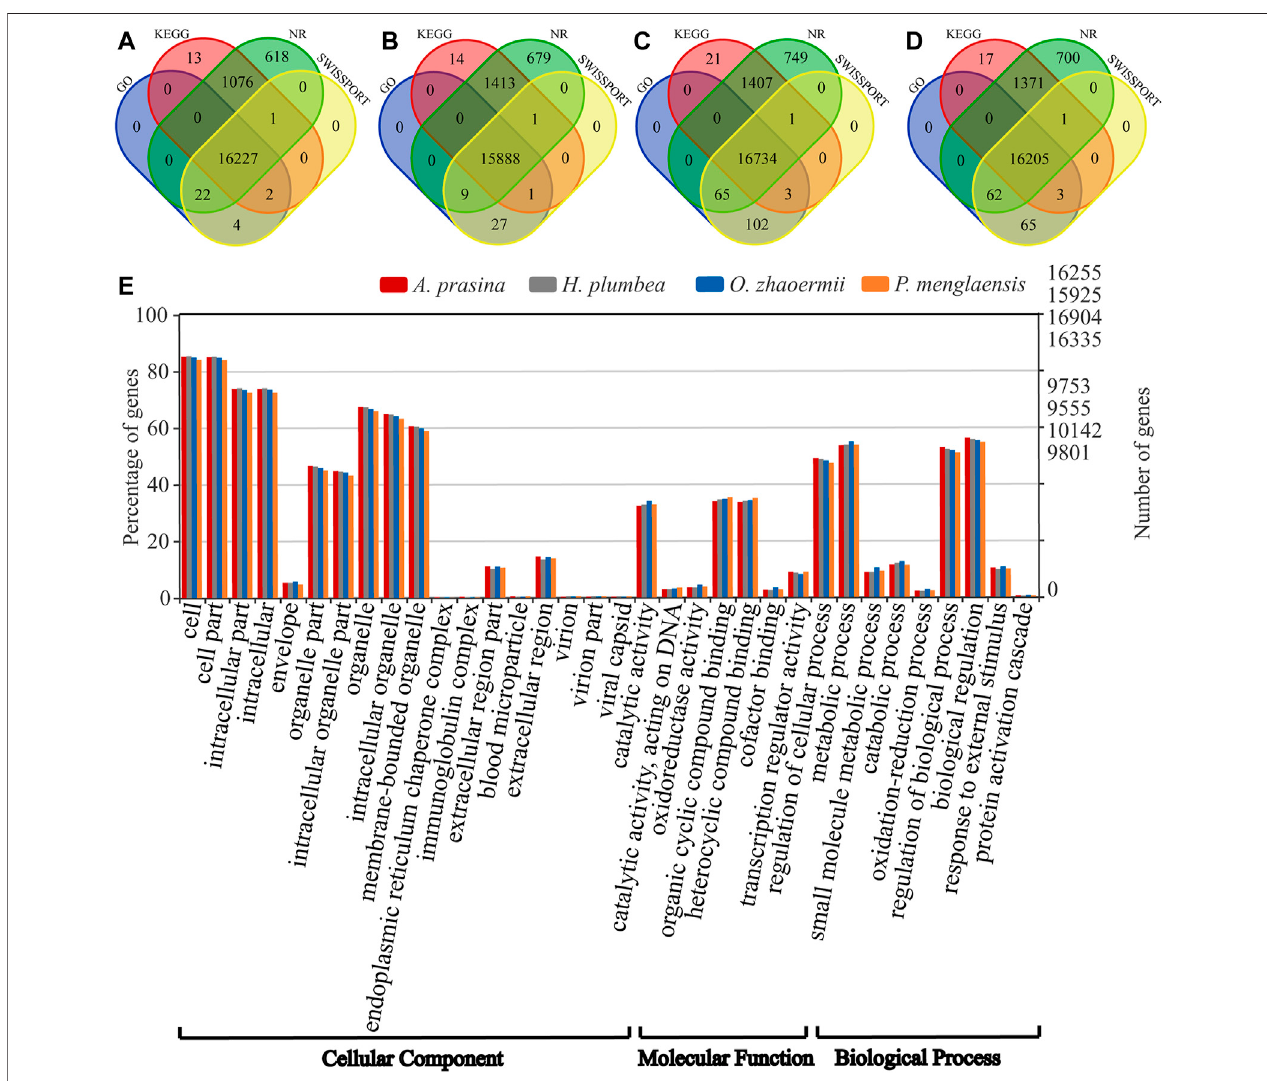
FIGURE2| Overviewofannotativesummaryof denovo transcriptomeassembly. (A – D) Venndiagramshowingthenumber ofspeci fi cand overlappingannotated unigenes between annotated results from four public databases. (A) Functional annotation of transcripts in of A. prasina . (B) Functional annotation of transcripts of H. plumbea . (C) Functional annotation of transcripts of O. zhaoermii . (D) Functional annotation of transcripts of P. menglaensis . (E) Comparison of Gene Ontology (GO) classi fi cations based on de novo transcriptome assembly of four species of